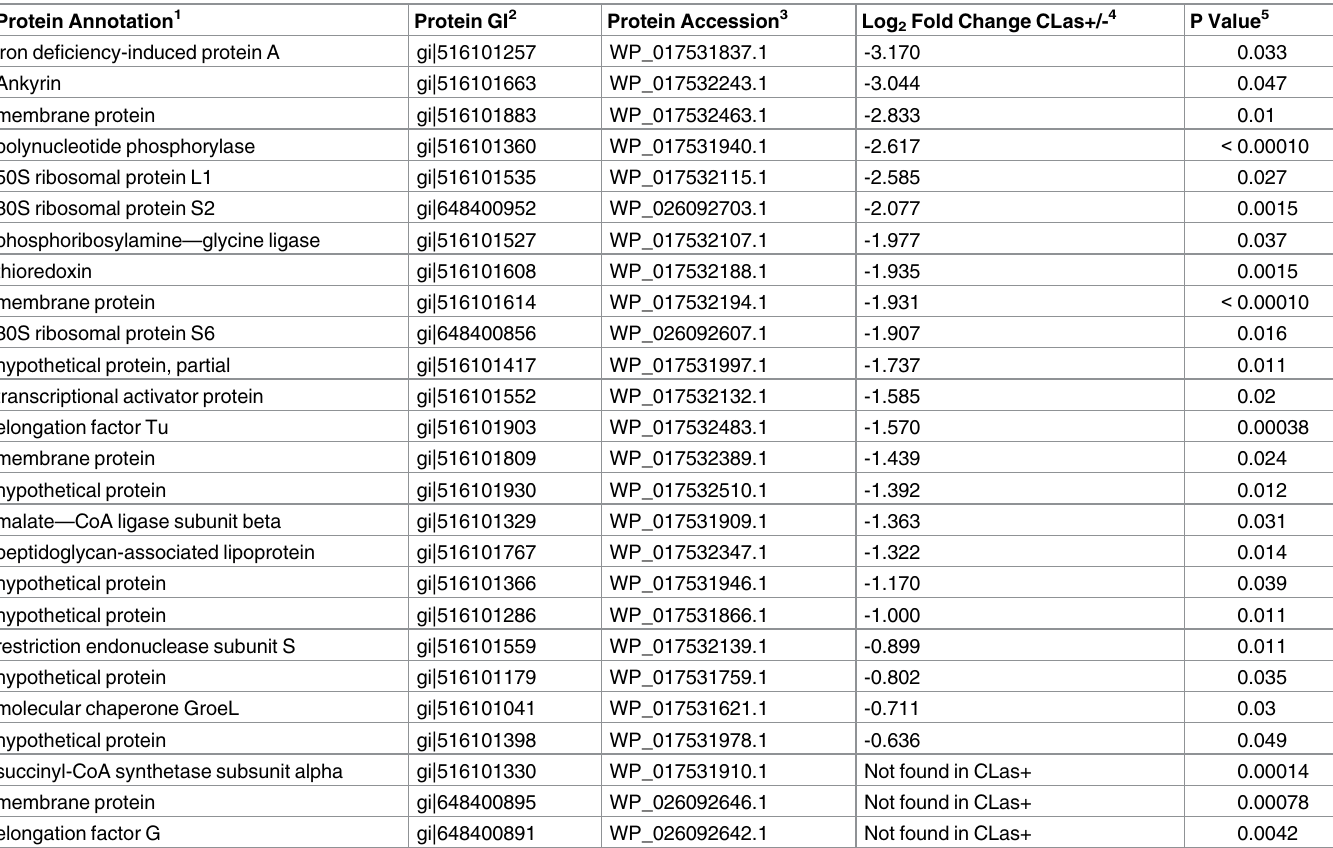
Table 2. Wolbachia proteins differentially expressedin CLas+ ACP